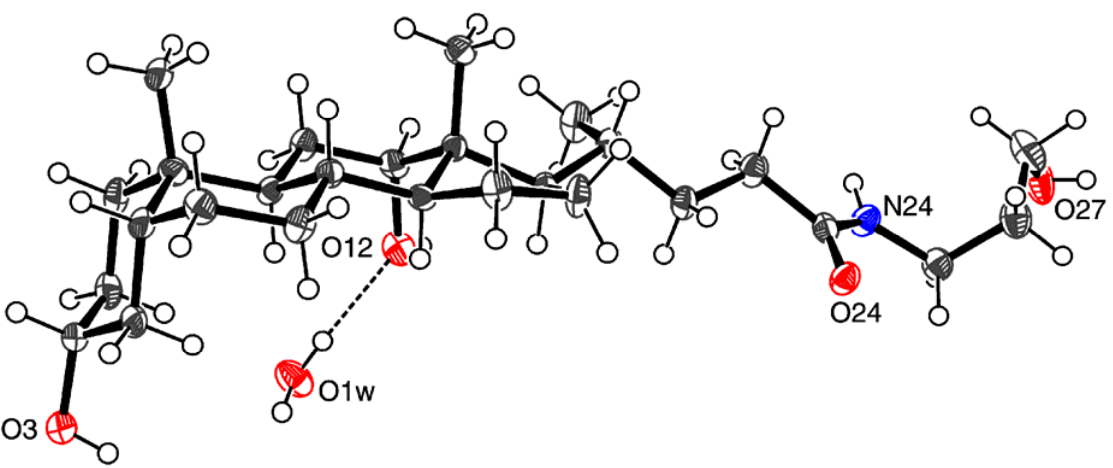
Figure 2. Asymmetric unit of monohydrate 3 . Thermal ellipsoids with 50 % probability